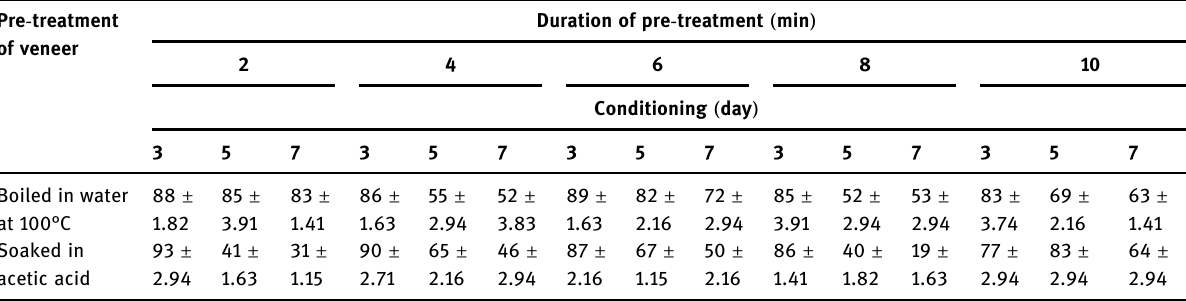
Table 2: Percentage of delamination of LVL Pre -